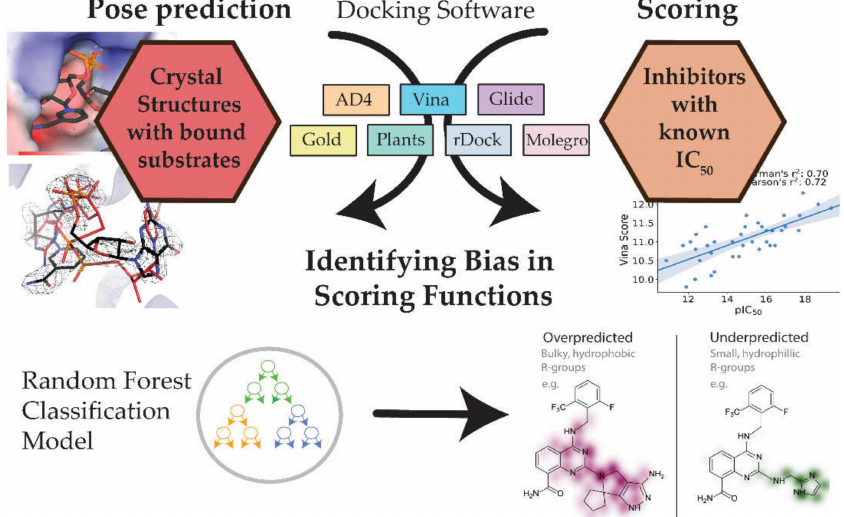
Figure 2. A summary of the of aims of this study, and a simplified workflow of the steps taken towards addressing these